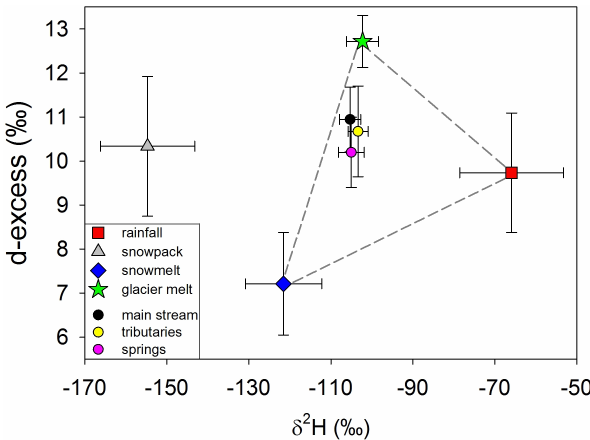
Figure 5. Mixing diagram between δ 2 H and d-excess of all average values of samples collected in the Saldur catchment. The error bars represent half of the standard deviation. The δ 2 H and d-excess com- position of rainwater samples was volume-weighted whereas the snow, snowmelt and glacier melt composition was not. The snow- pack is excluded from the mixing space because it is not a direct hydrological